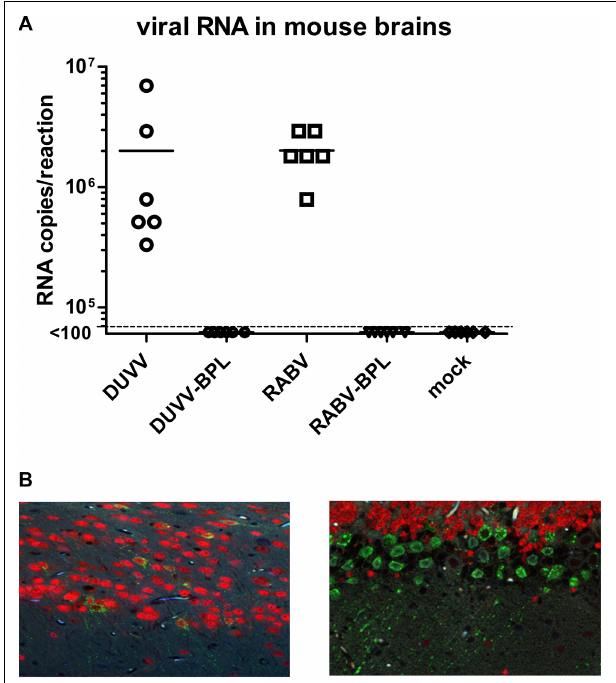
FIGURE 1 | Infection of BALB/c mice with DUVV-NL07 and RABV-PV. (A) Viral RNA in the mouse brains at 5 d.p.i. Dotted line represents the limit of detection of the assay ( < 100 copies of RNA per reaction). (B) Extensive infection of pyramidal neurons of the hippocampus by DUVV-NL07 (left) and of the Purkinje cells of the cerebellum by RABV-PV (right). Tissues were stained with a polyclonal antibody that recognizes the N protein of RABV and observed at 20 × magnification. Green, RABV antigen; red, NeuN staining for